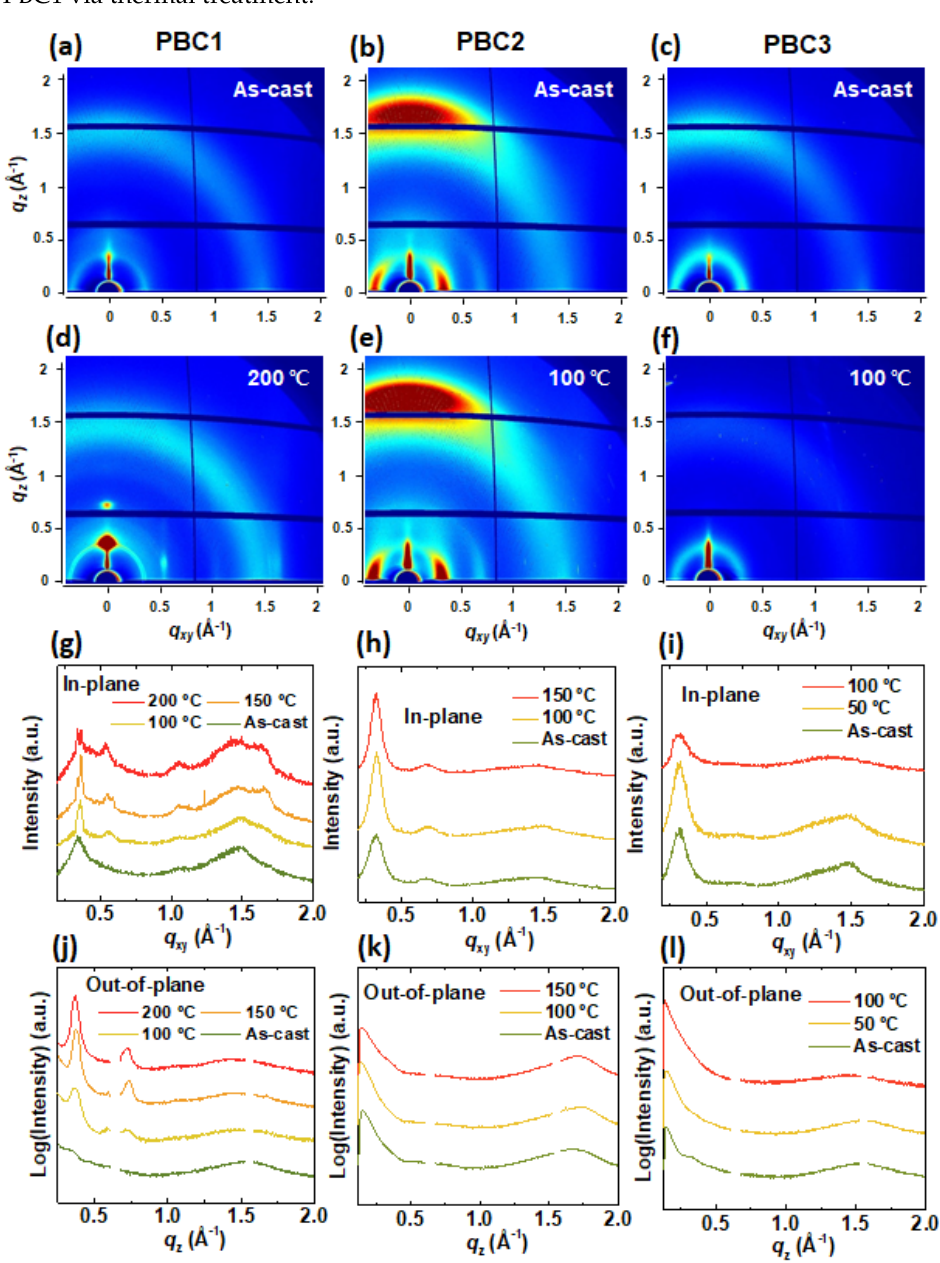
Figure 3. Two ‐ dimensional grazing incidence X ‐ ray diffraction patterns of as ‐ casted ( a ) PBC1, ( b ) PBC2 and ( c ) PBC3 films, and thermally ‐ annealed ( d ) PBC1, ( e ) PBC2 and ( f ) PBC3 films. The corresponding line ‐ cut profiles of ( g , j ) PBC1, ( h , k ) PBC2, and ( i , l ) PBC3 films along the in ‐ plane ( q xy ) axes ( g – i ) and out ‐ of ‐ plane ( q z ) and ( j – l ).